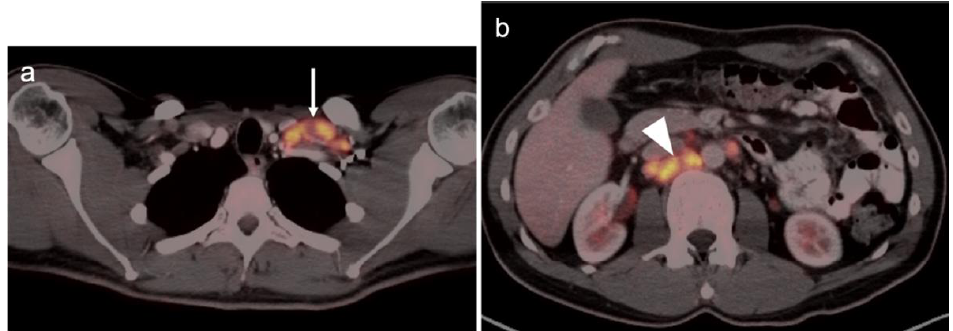
Figure 45. Intensely hypermetabolic metastatic embryonal germ cell tumor of the testis on FDG PET-CT to lymph nodes in the left supraclavicular region ( a , white arrow) and the retroperitoneum ( b , white arrow).